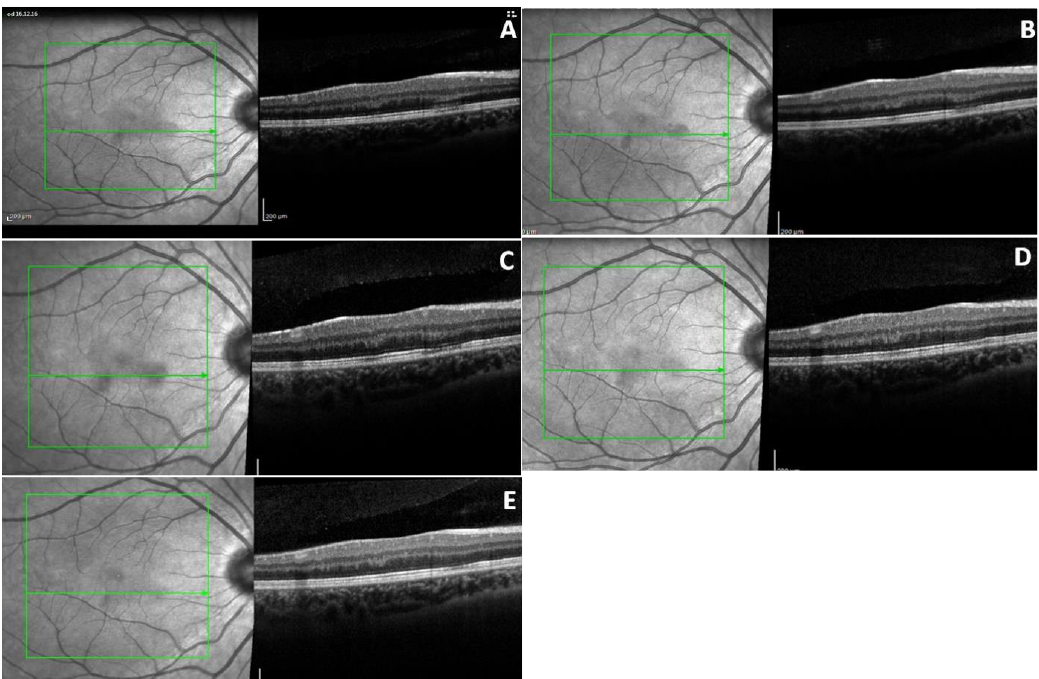
Figure 2. OCT and infrared images (IR) of right eye. ( A ) At presentation IR shows two hyporeflective parafoveal lesions. Corresponding OCT shows two hyperreflective band of outer plexiform layer (OPL) and outer nuclear layer (ONL), and alteration of inner segment/outer segment (IS/OS) and retinal pigment epithelium RPE in the region of the bigger lesion in IR (nasally). ( B ) Image one week later. ( C ) 40 days month later, the OCT features started to normalize. ( D ) One year later the OCT shows a smaller band in the OPL corresponding to the smaller lesion in IR (infero-temporally). ( E ) 30 months later the lesions on the IR image are strongly reduced and there are rare hyperreflective spots in the OPL and hyporeflective band of the ellipsoid zone. Diagnostics 2020 , 10 , x FOR PEER REVIEW